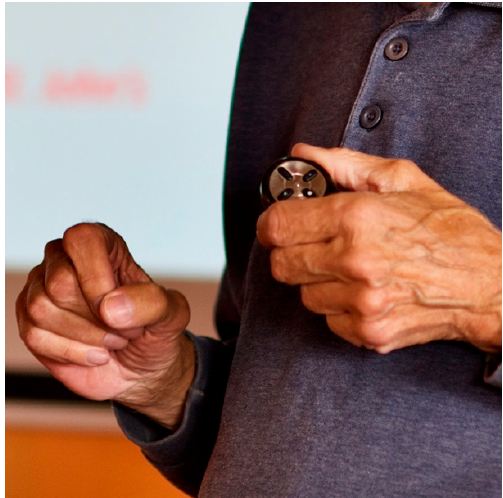
Figure 2. Peter Day’s hands during a lecture on Scientific Tourism at NoSiC-8, 8 June 2018. Photo: S. Alvarez.